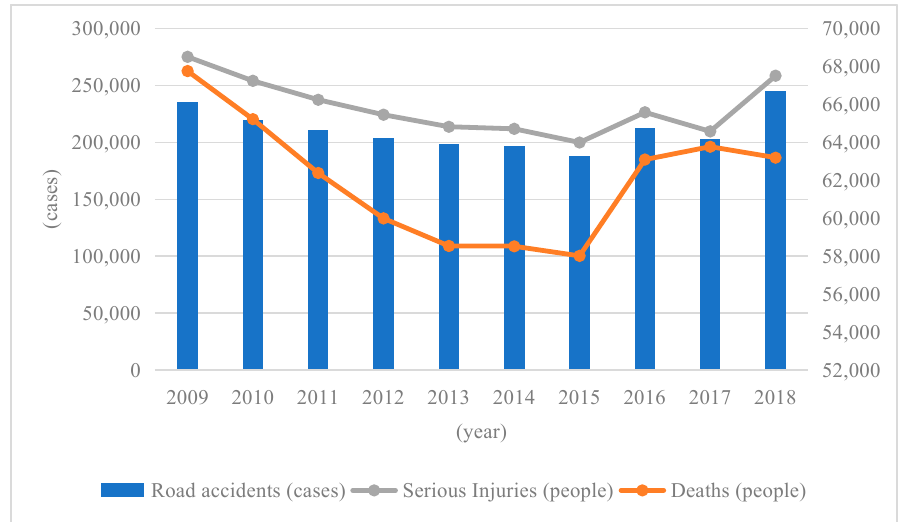
Figure 5. The number of road accidents and casualties in China from 2009 to 2018.